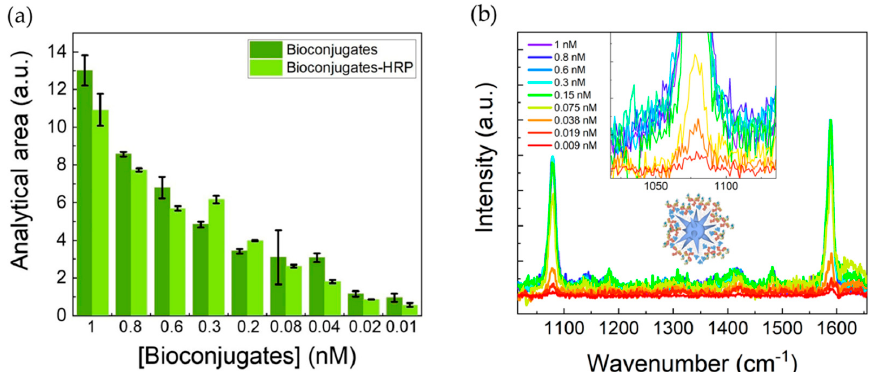
Figure 6. ( a ) SERS line areas for bioconjugates with and without a bound HRP antigen. Analytical areas presented are from the 1079 cm − 1 line of MBA. ( b ) SERS spectra from all the performed dilutions for bioconjugates with bound HRP antigens. These concentrations are related to the concentration determined for AuNSs after